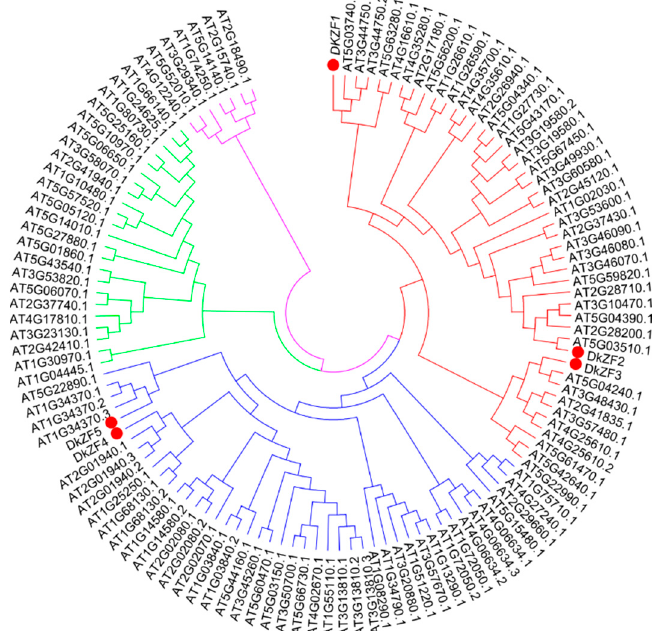
Figure 1. Phylogenetic analysis of DkZFs. Phylogenetic analysis was conducted with DkZFs and zinc finger of Arabidopsis thaliana (ZAT). Red, blue, green, and purple colors indicate clades/subtypes I, II, III, and IV of ZFs respectively, while red circles indicate DkZF transcription factors.